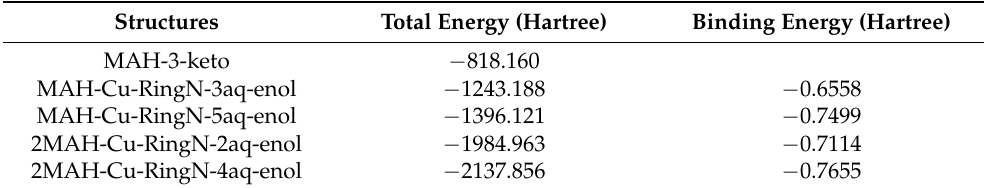
Table 1. Total and binding energies of MAH and MAH-Cu(II)